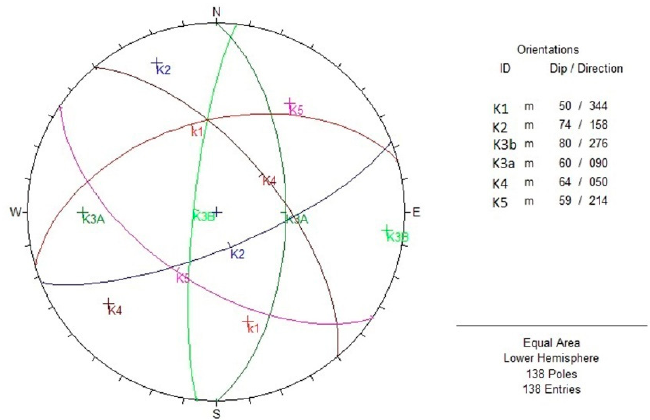
Figure 3. Plot reporting the main discontinuity sets obtained by processing scanlines data.